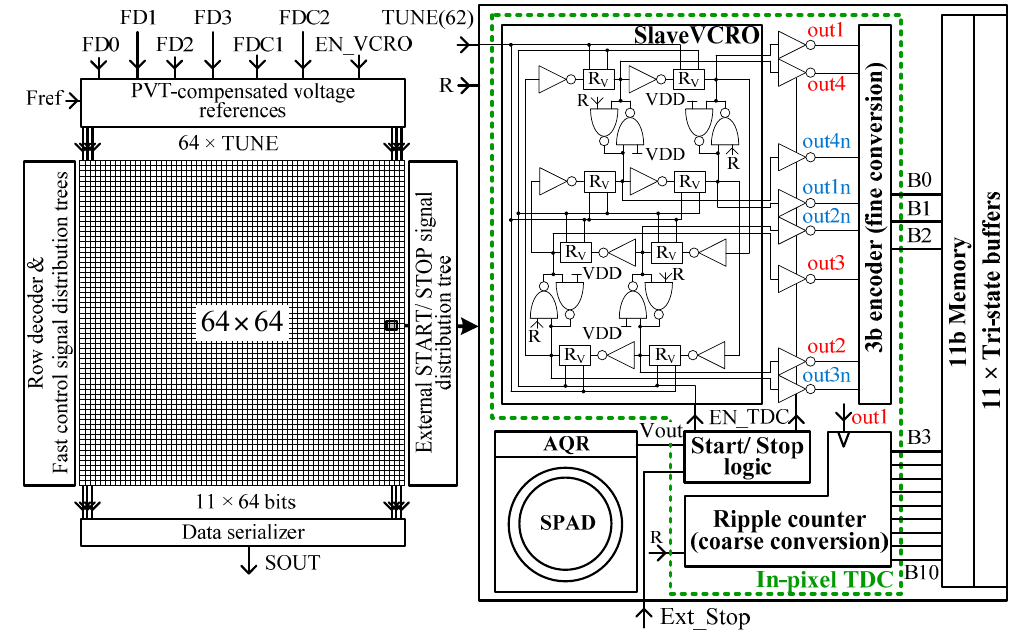
Figure 1. Chip diagram incorporating the compensation of process parameters, voltage supply and temperature (PVT) variations.